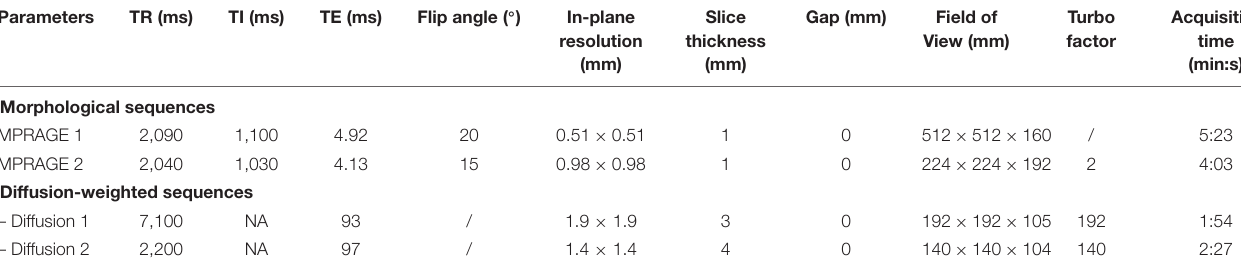
TABLE 1 | Morphological and diffusion weighted sequences parameters.